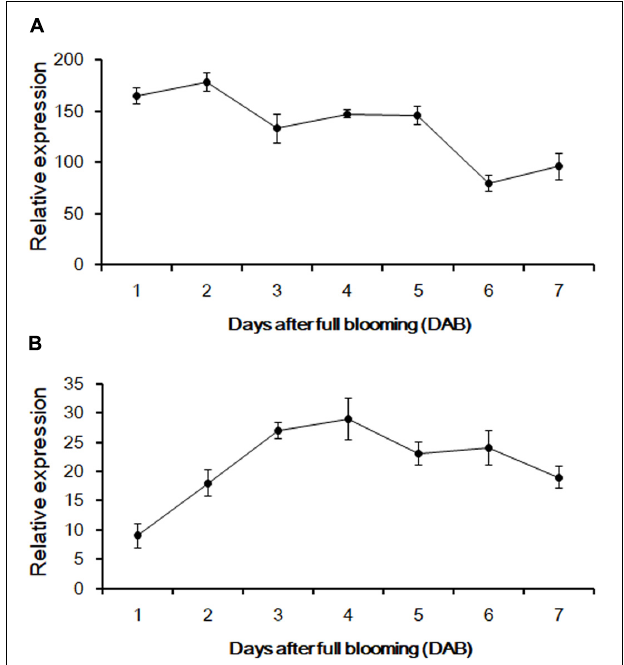
FIGURE 4 | Relative expression of CsUGT76F1 in sweet orange peels (A) and pulp (B) during fruit development. Data represent means with standard deviations ( n =